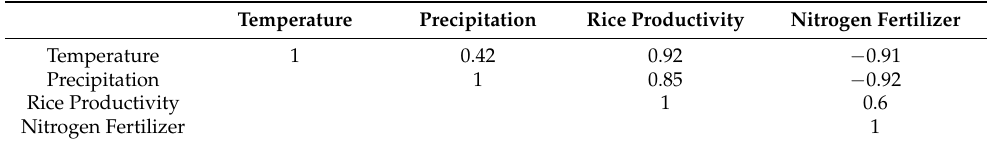
Table 5. Pearson correlation coefficient between modeled temperature, precipitation, rice productivity and nitrogen